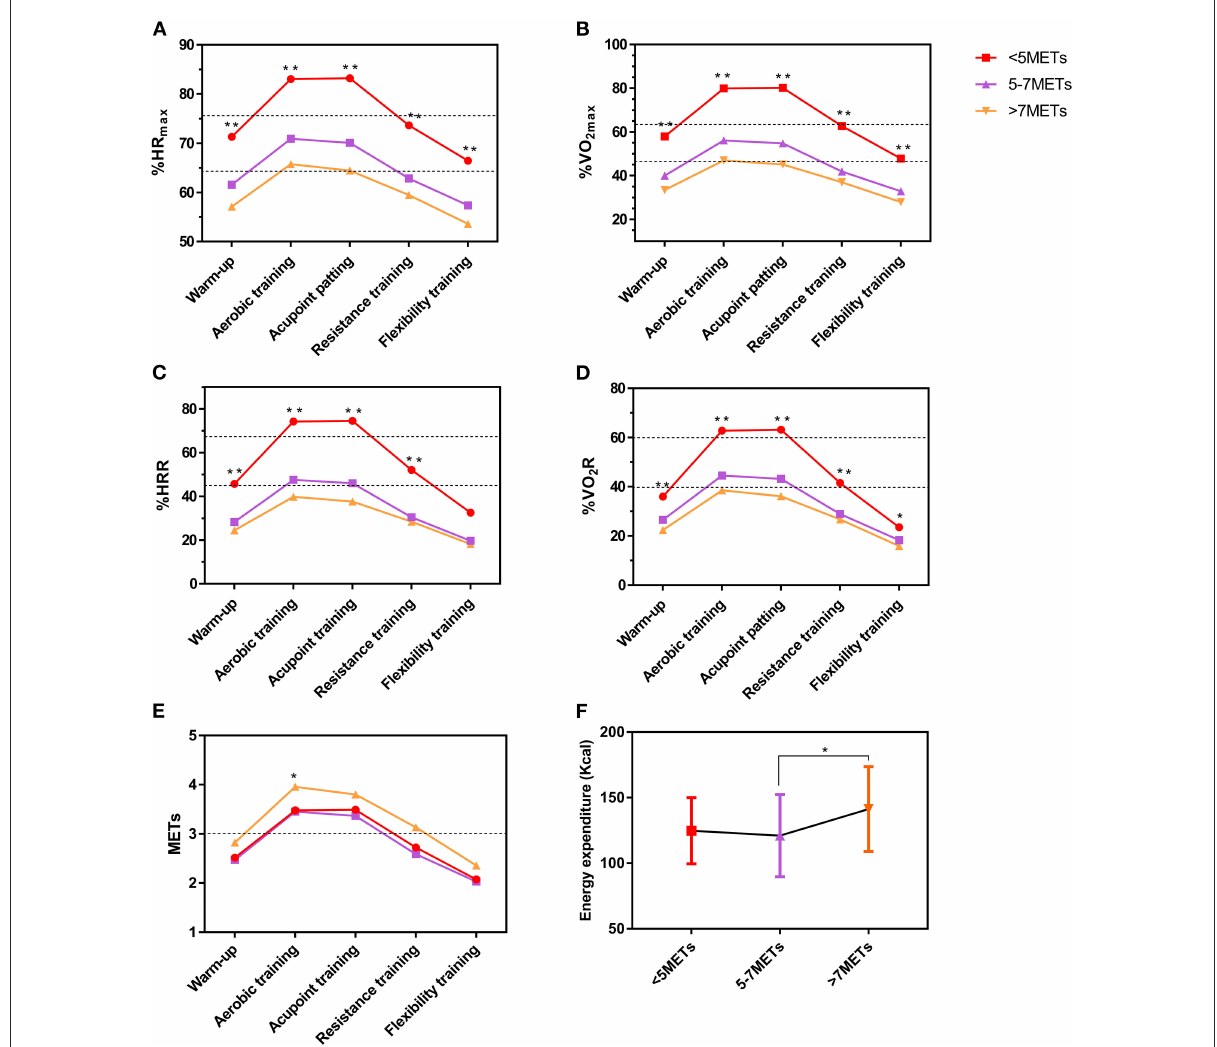
FIGURE4 The exercise intensity and energy expenditure of the X-CircuiT program between different peak METs value groups. (A) Shows the peak heart rate percentage (%HR peak ); (B) Shows the peak oxygen intake percentage (%VO 2peak ); (C) Shows the heart rate reserve percentage (%HRR); (D) Shows the oxygen uptake reserve percentage (%VO 2 R); (E) Shows metabolic equivalent (METs); and (F) Shows the energy expenditure of X-CircuiT. The dotted lines are the medium intensity exercise (lower line) or high intensity (higher line) exercise boundary. * Indicates the difference of the corresponding stage between groups p < 0.05; and ** indicates the difference between groups p < 0.01